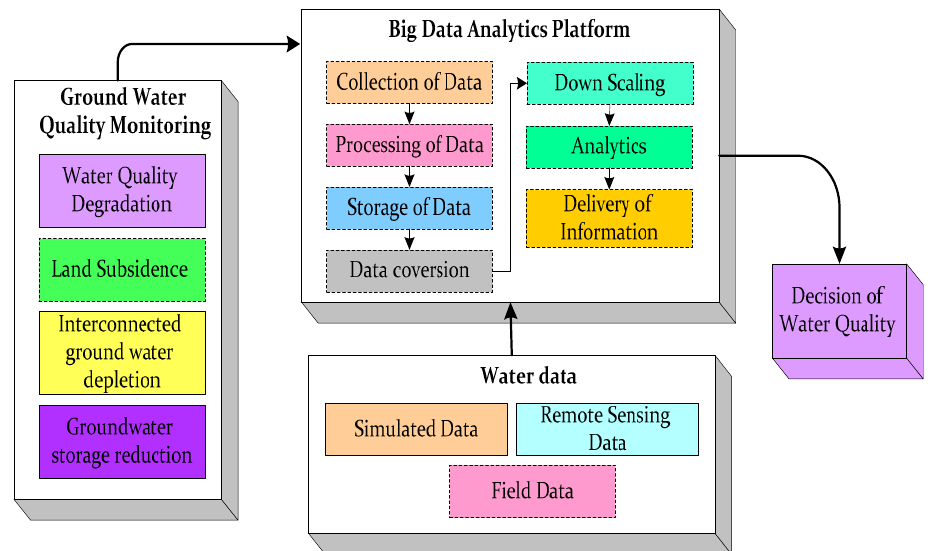
Figure 1. Big data-based framework for water quality analysis.